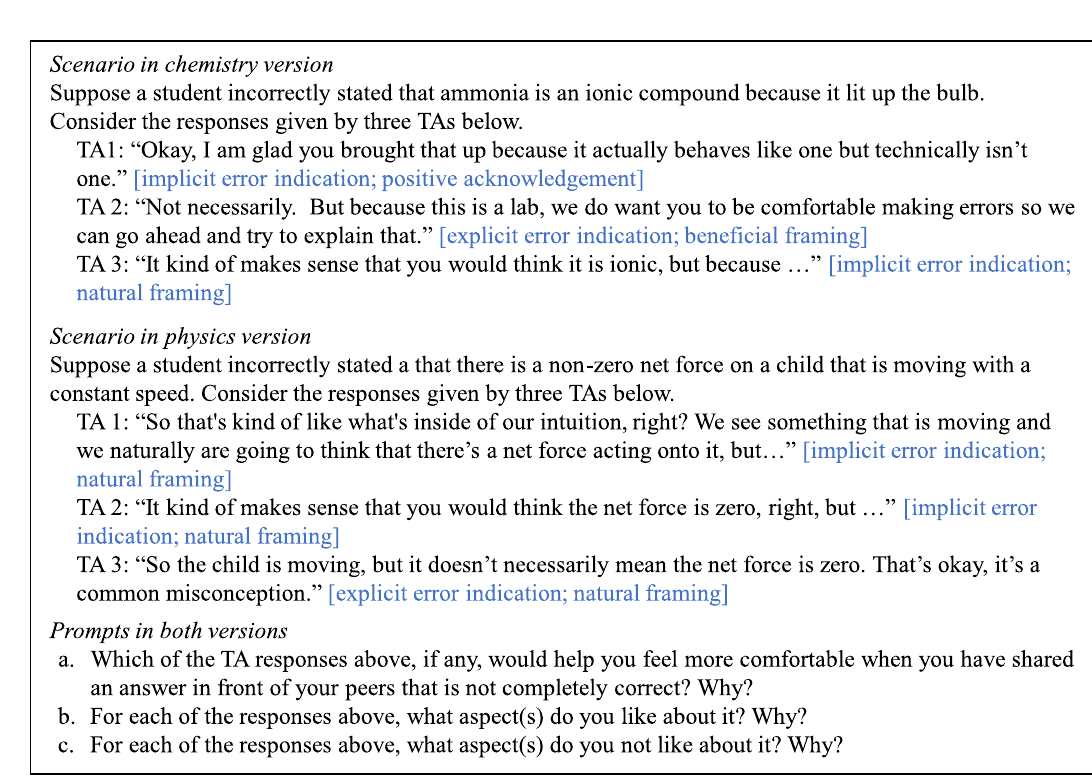
Fig. 1 Chemistry and Physics versions of interview protocol. The coding of GTA statement is shown in square parentheses. Note that the coding was not shown to students during interviews